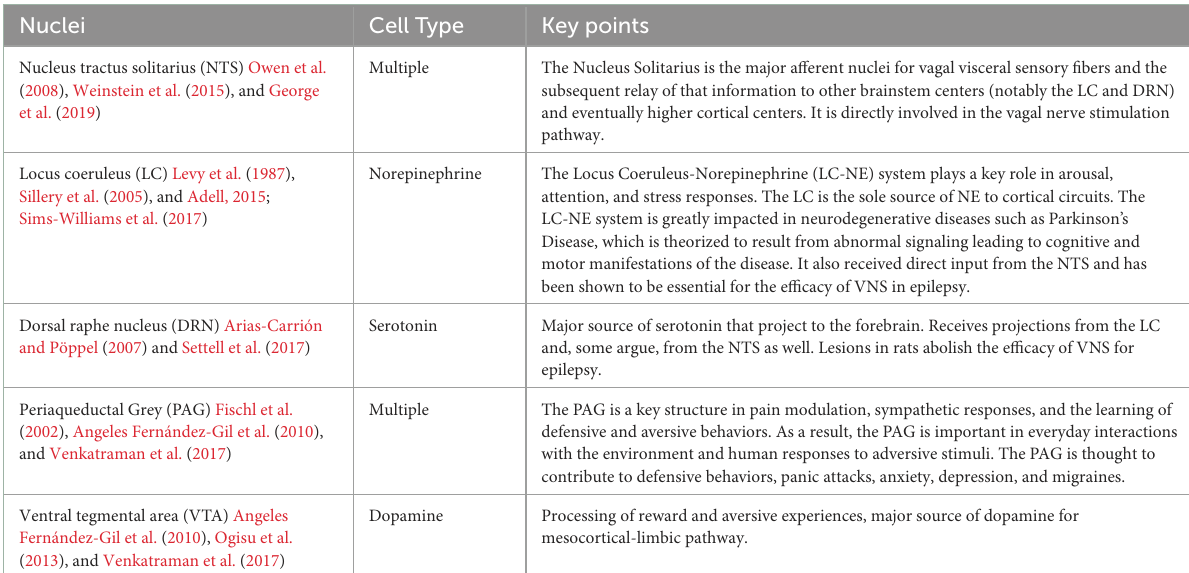
TABLE 1 Limbic brainstem nuclei key